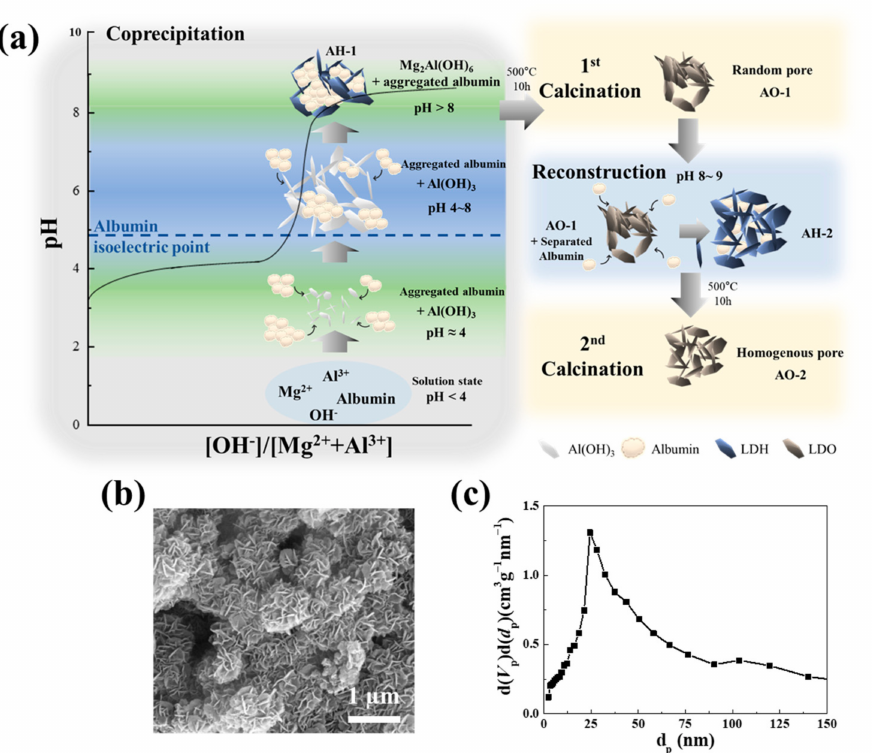
Figure 9. ( a ) Schematic diagram to produce MMOs from either coprecipitated albumin-LDH or reconstructed albumin-LDH. ( b ) SEM image (obtained by FEI QUANTA 250 FEG, Hillsboro, OR, USA) and ( c ) pore size distribution of MMO obtained from reconstructed albumin-LDH (obtained by BELSORP-mini II, Microtrac BEL, Inc., Japan) (adapted with the permission from Jung et al. [48]. Copyright